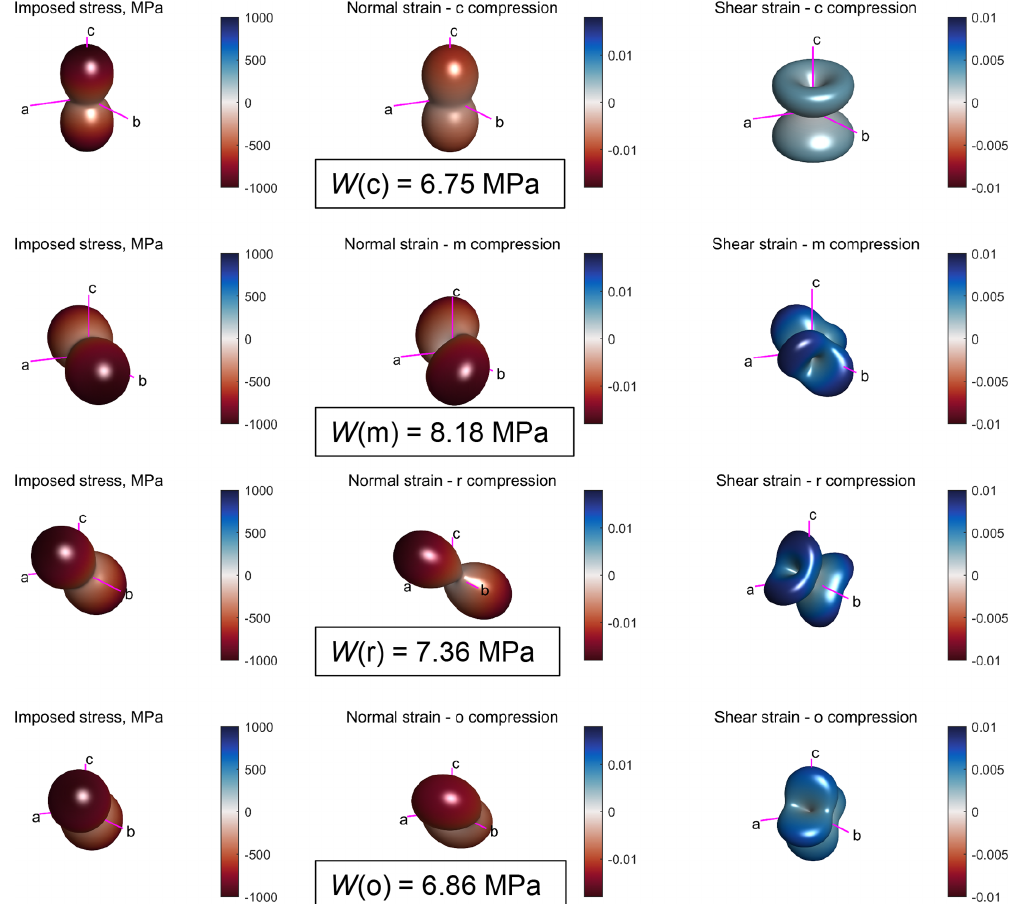
Figure 19. Variation in strain (normal and shear) and elastic strain energy for different applied loads in α -quartz at 500 ◦ C (Lakshtanov et al., 2007). The same compressive stress ( σ 1 = − 1000MPa, σ 2 = σ 3 = − 300MPa) is applied along the c (first row), m (second row), r (third row) and o (fourth row) directions in a single crystal. The Reynolds (second column) and HWY (third column) glyphs show the normal and shear strains, respectively. The elastic strain energy per unit volume ( W ) is shown for each configuration. Note that W(m) > W(r) > W(o) > W(c) .